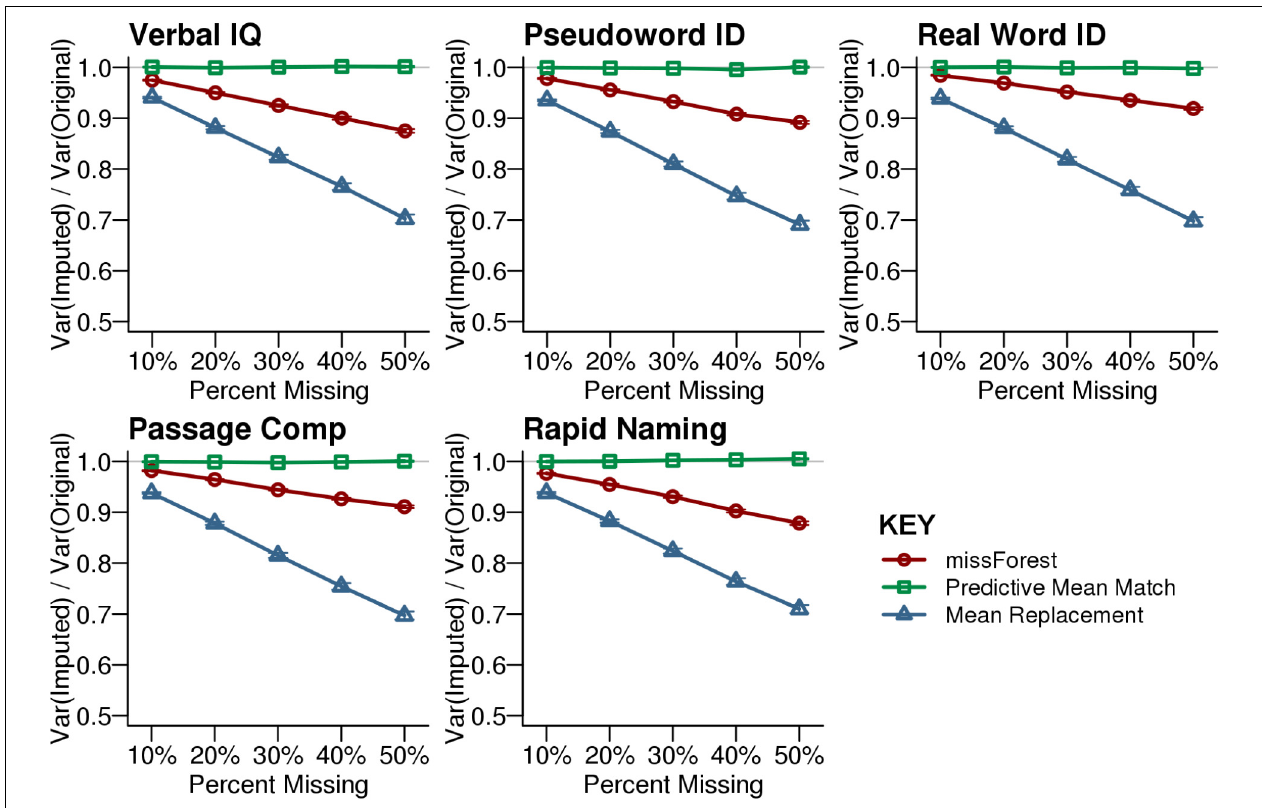
FIGURE 2 | Efficiency for the imputed synthetic data. Efficiency is calculated by dividing the variance of the imputed dataset by the variance of the original dataset that had no missing data. Predictive Mean Matching provided the best approximation of the original variance across the tested levels of simulated missingness at random. The missForest imputed dataset exhibited less variance than the original dataset. Mean Replacement demonstrated the lowest efficiency with increasing missingness. Each point shows the average with SEM error bars calculated across 1,000 simulations.